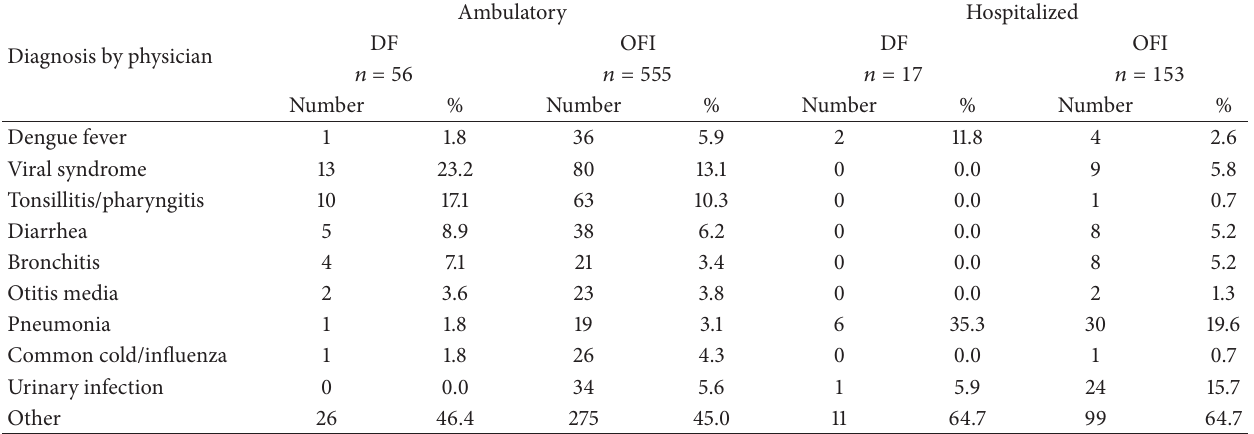
Table 4: Clinical diagnosis of laboratory-confirmed dengue fever cases and other febrile illness cases in ambulatory and hospitalized patients, Medellin, Colombia, March